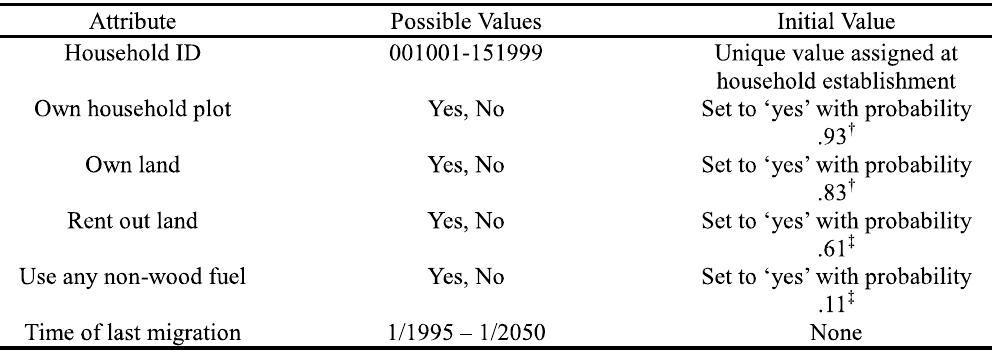
Table A1.2: Attributes of the 'household' agent type. From CVFS data Axinn and Ghimire